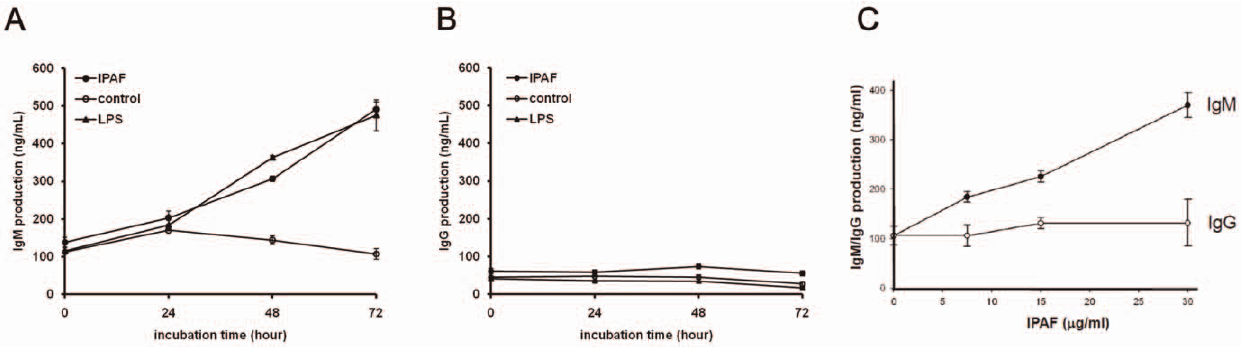
Figure 5. IPAF enhanced IgM production in purified mouse B lymphocytes. (A) IgM production and (B) IgG production by MACS-purified CD19 + B lymphocytes of BALB/c were treated with 30 m g/mL of IPAF ( N ), medium ( # ), or 10 m g/ml LPS ( m ) for 0, 24, 48 and 72 hours. The Igs production was determined by ELISA. Results are shown as mean 6 SD in triplicate (n=3). (C) B lymphocytes of BALB/c were treated with IPAF of indicated concentrations for 48 hours. IgM ( N ) and IgG ( # ) production were determined by ELISA. Results are shown as mean 6 SD in triplicate (n=3).